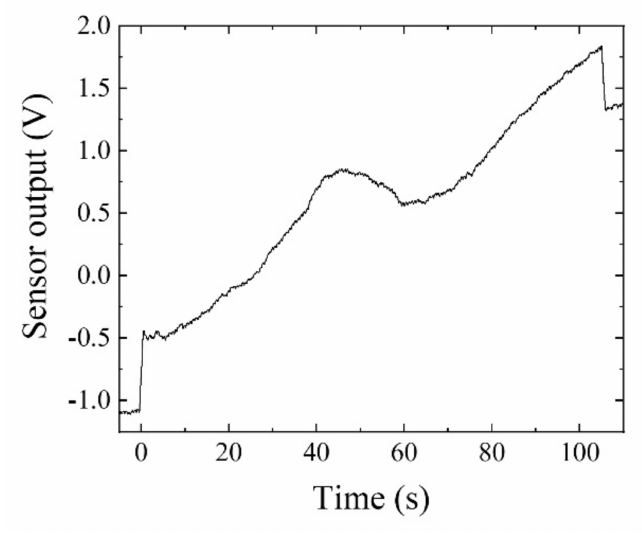
Figure 17. Typical measurement result without magnetic chip. (Feeding speed: 10 mm/s).